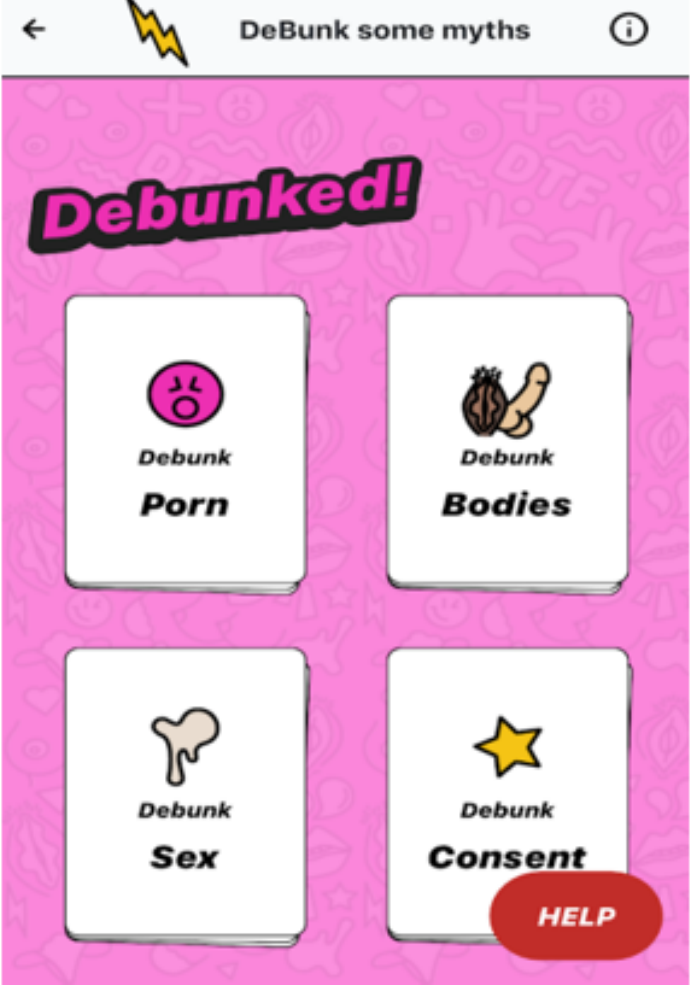
Figure 6. The Gist ‘Debunked’activity to challenge pre-held knowledge and